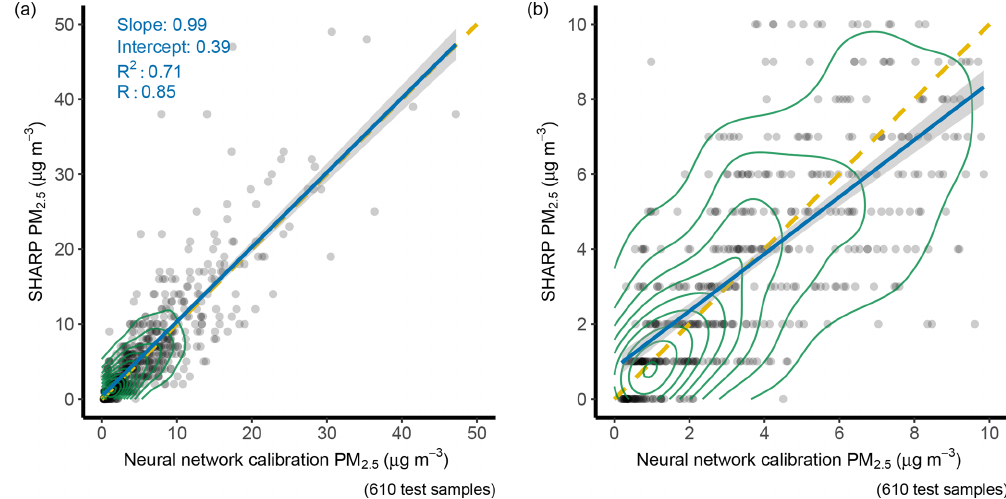
Figure 11. Comparison between the NN predictions and SHARP. Based on 610 test examples. Panel (a) is in full scale. Panel (b) is a zoom-in plot of panel (a) . The solid blue line is a regression line. The yellow dashed line is a 1 : 1 line. The green circle represents data density. The grey area along the regression line represents 1 standard deviation.